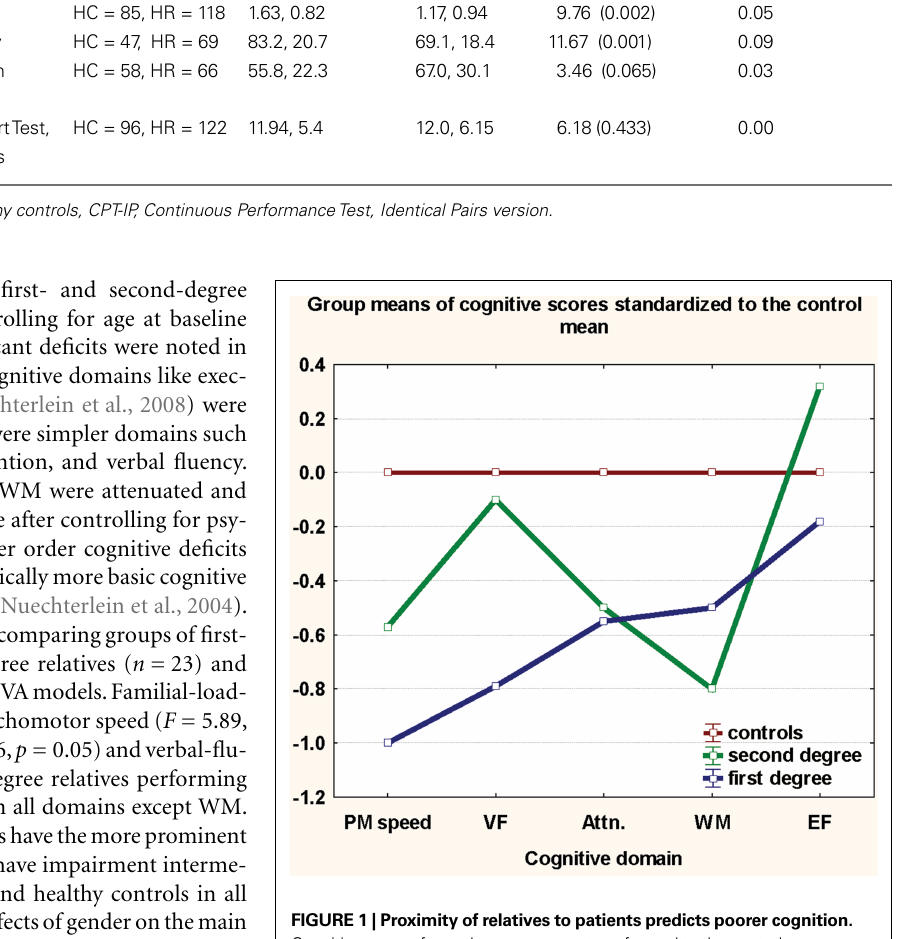
FIGURE 1 | Proximity of relatives to patients predicts poorer cognition. Cognitive scores for each group were z-transformed to the control mean. Group-means of the z -scores are plotted on the y -axis. PM, psychomotor; VF, verbal fl uency; EF, executive function; Attn, attention; WM, working